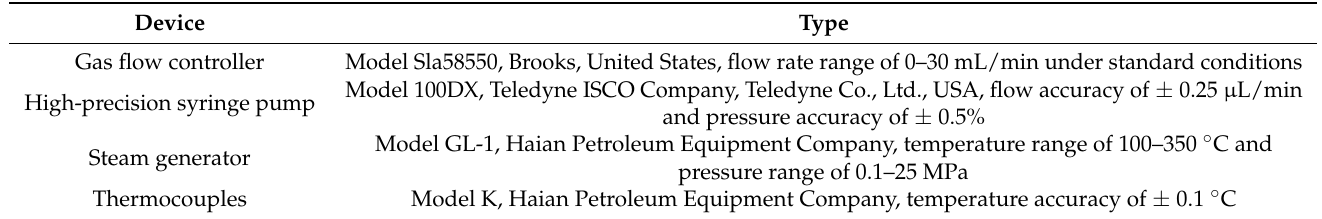
Figure 2. Schematic diagram of the experimental setup in the laboratory. Table 2. Relevant parameters of experimental